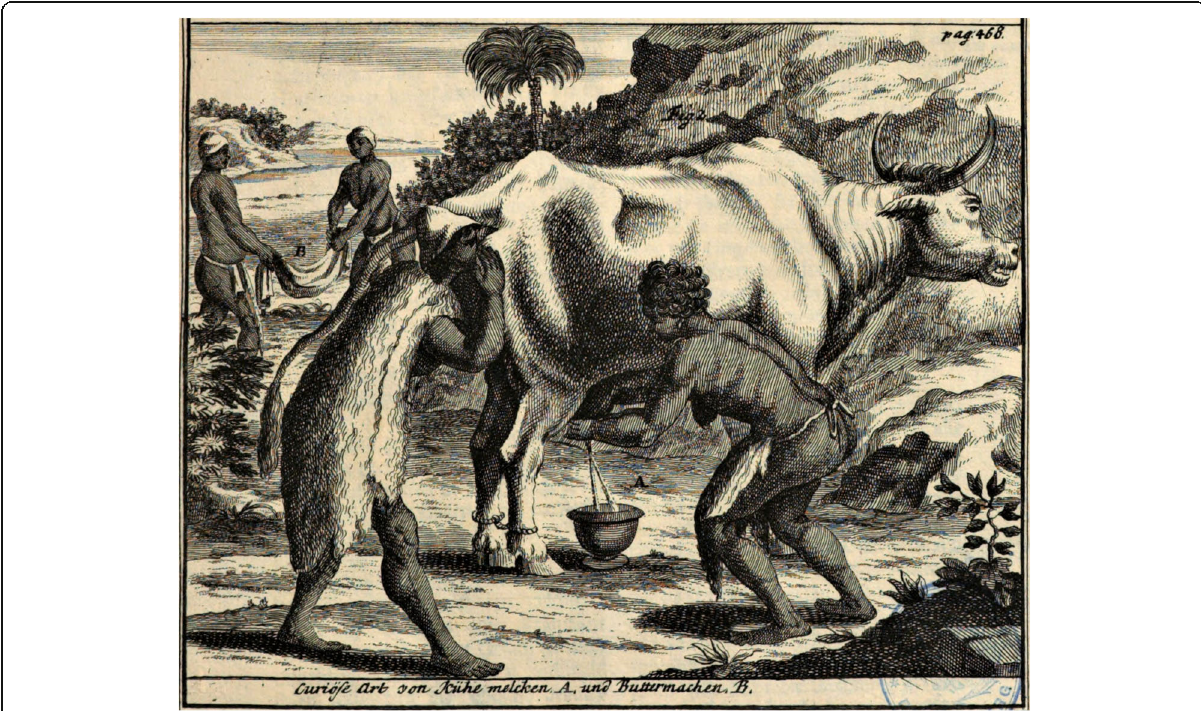
Fig. 7 Engraving from the book by Peter Kolb illustrating the practice of cow insufflation in his description of the “ Hottentos ” of the Cape (after Kolb 1719: 468)